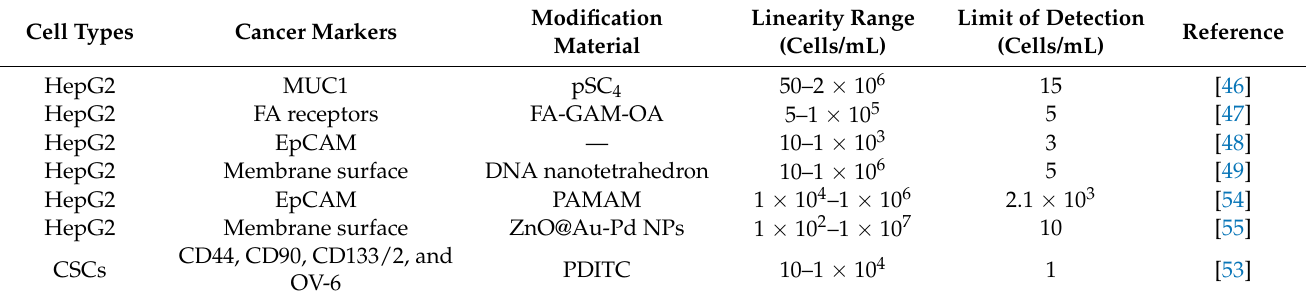
Table 4. Electrochemical cytosensors used for liver cancer cell